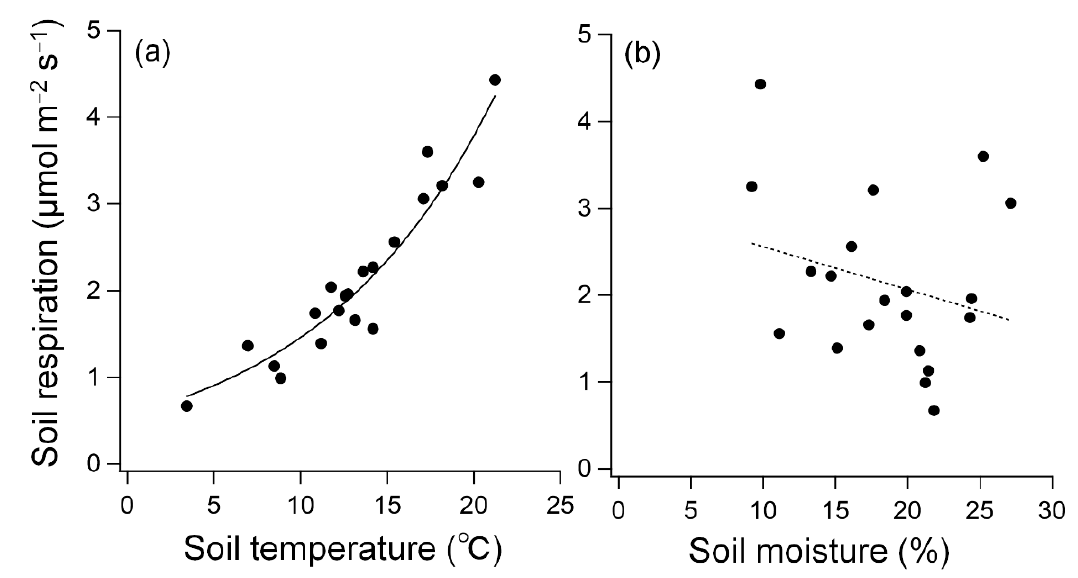
Figure 2. Relationships between soil respiration, ( a ) soil temperature, and ( b ) soil moisture in Larix kaempferi forest. Solid line indicates the regression line for all data; p < 0.05, while a dashed line indicates for all data; p > 0.05. Table 1. Estimated parameters ( α and β ) and coefficient of determination from Equation (1) for R soil , R root , R myc , and R som during growing season in Larix kaempferi forest. R soil R root R myc R som α 0.5210 0.1346 0.0086 β